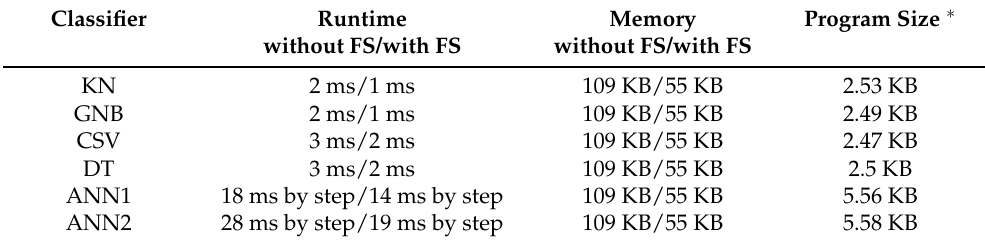
Table 2. Efficiency and complexity results by classifier; KN: K-Neighbors; GNB: Gaussian Naive Bayes; CSV: C-Support Vector; DT: Decision Tree; ANN1: Artificial neural network with a single hidden layer; ANN2: Artificial neural network with two hidden layers; FS: Feature selection; ∗ the differences of program size were negligible without, and with